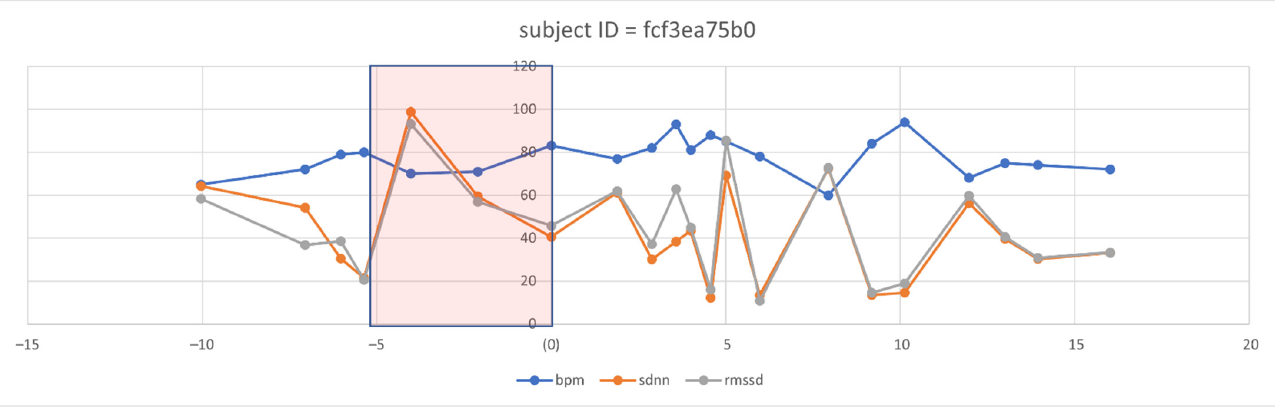
Figure 8. Observation of selected HRV features and BPM overtime in one subject before and after the ‘ ‘symptom’s onset.